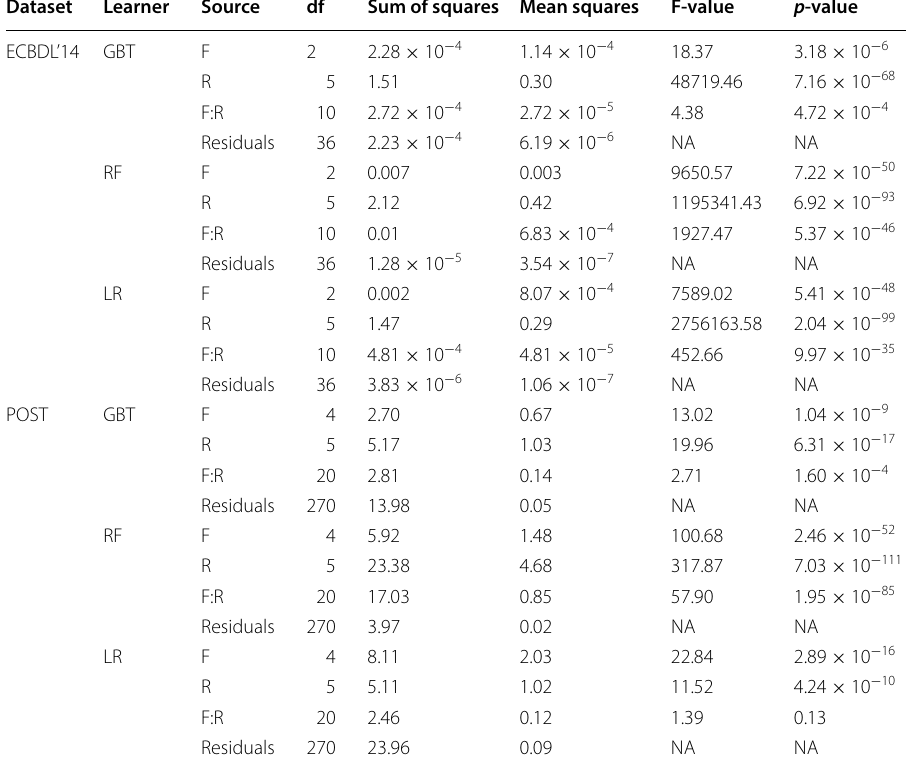
F features subset, R sampling distribution ratio